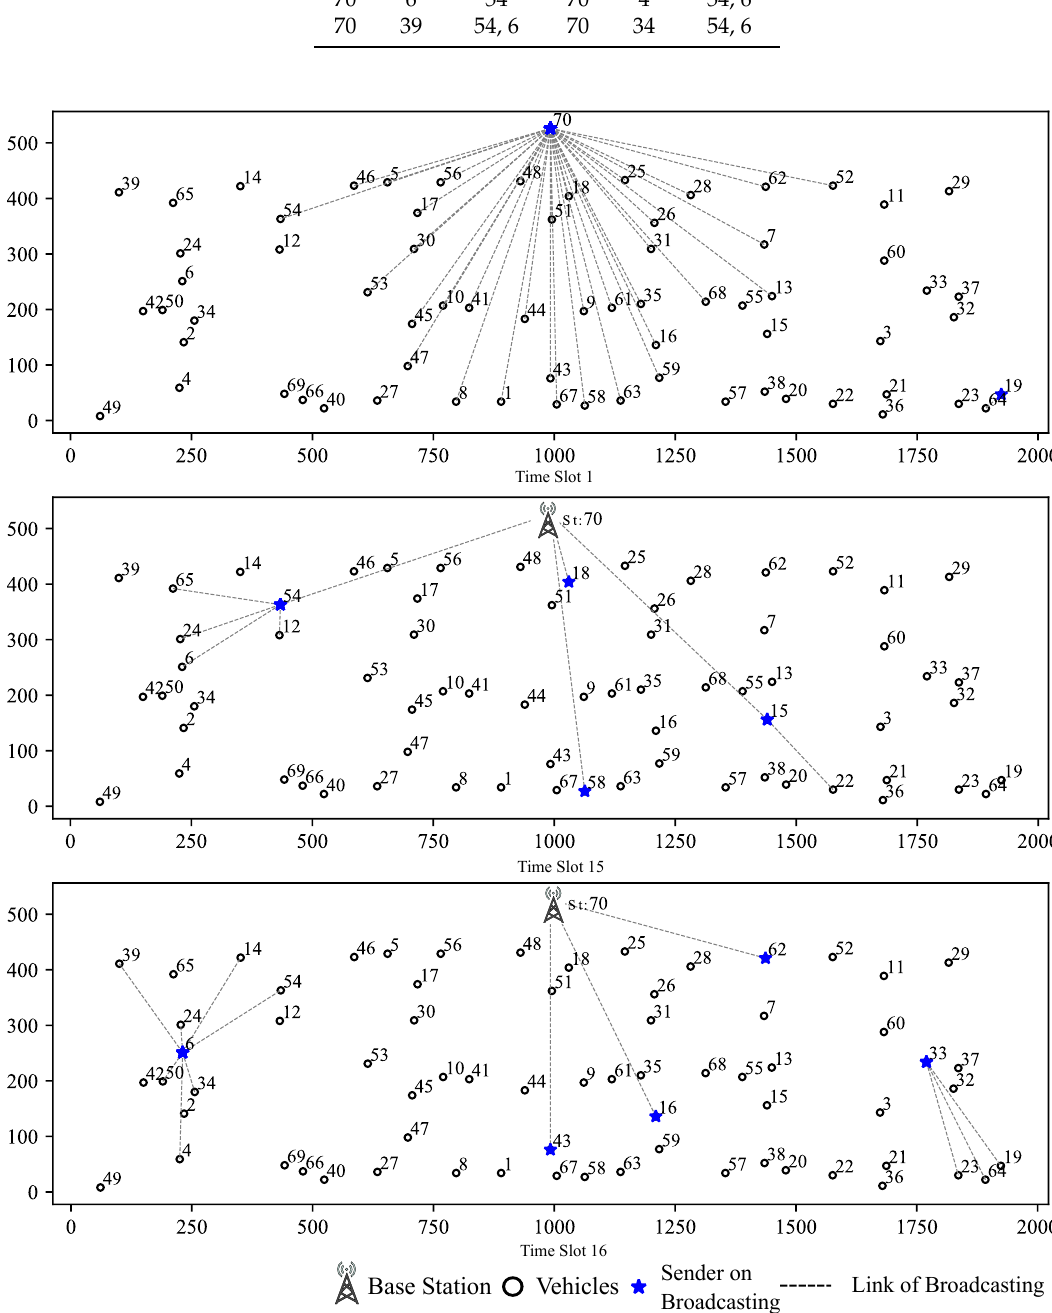
Figure 16. An Example of I → V Session Routes from Base Station to Vehicles out of Vommunication